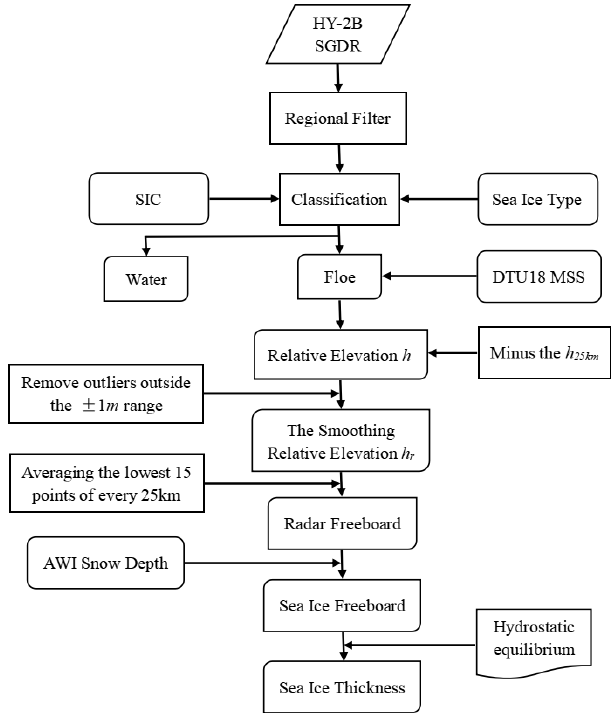
Figure 2. A flowchart of the sea ice thickness retrieval